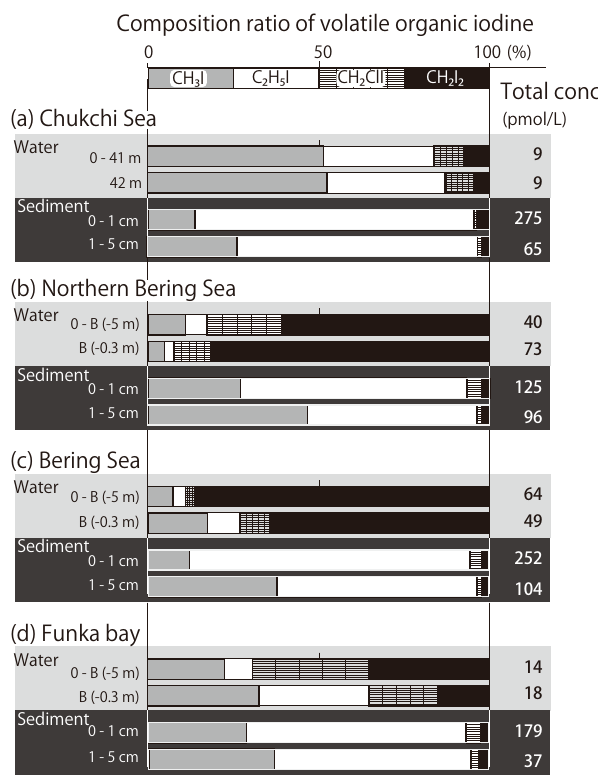
Fig. 3 VOIs in water column and sediment in Bering and Chukchi Seas. a Proportional composition (%) of VOIs and their total concentrations (pmol L – 1 ) in the water column and sediment in Chukchi Sea. b Northern Bering Sea. c Bering Sea. d Funka bay. Proportion of CH 3 I, C 2 H 5 I, CH 2 ClI, and CH 2 I 2 are shown in boxes with gray, white, shade, and black, respectively. The water column was divided into two layers: near-bottom water and the upper water column. The values for the northern Bering Sea and Bering Sea are averages for each area, and the values for Funka Bay are total averages for the time-series observations. Water depths of B ( − 5 m) and B ( − 0.3 m) are depths 5 m and 0.3 m above the bottom,